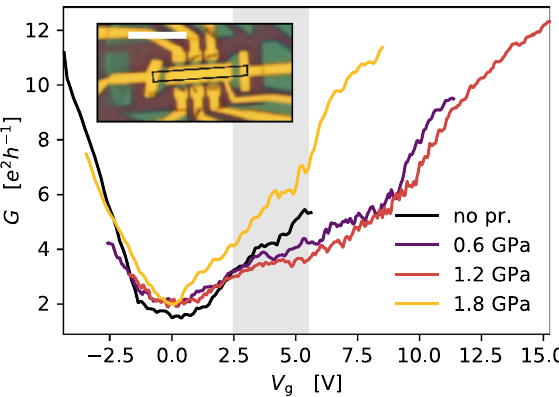
Fig. 2 Two-terminal conductance vs. back gate voltage measure- ments at different pressures. The curve minima, assumed to be the CNP, are shifted to V g = 0 to maintain comparability of the curve shapes. The area considered for the comparison of the WAL signals, between 2.5 and 5.5 V, is highlighted by the gray background. Inset: Optical micrograph of the sample. Scale bar is 10 μ m. The highlighted segment is measured in two-terminal measurements at 1.5 K for all